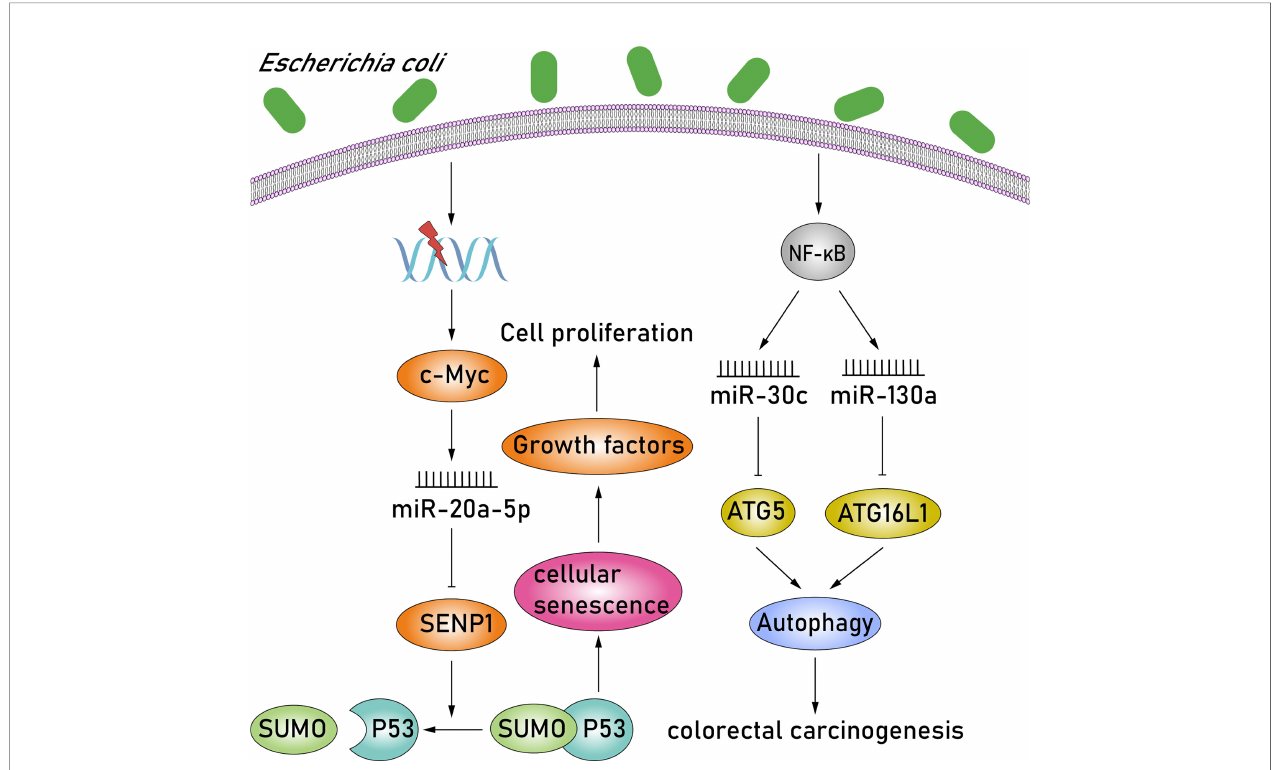
FIGURE 3 | E. coli promotes cell proliferation and in fl ammation by modulating miR-20a-5p, miR-30c, and miR-130a. In pks + E. coli – infected CRC cells, c-MYC is activated, and it subsequently results in the upregulation of miR-20a-5p. Upregulation of miR-20a-5p can cause the translational silencing of target SENP1. SENP1 is a key enzyme that blocks the modi fi cation of the SUMO1-conjugated p53 patterns. Moreover, the SUMOylation of p53 is identi fi ed as the key regulator of cellular senescence. The senescence of intestinal epithelial cells in pks + E. coli – infected CRC cells consequently induces the secretion of growth factors, which play a crucial role in stimulating tumor growth. In addition, expressions of miR-30c and miR-130a were also upregulated signi fi cantly in AIEC-infected epithelial cells via activating the NF- k B pathway. Overexpression of miR-30c and miR-130a subsequently downregulates the expression of ATG5 and ATG16L1, respectively. ATG5 and ATG16L1 are members of autophagy signaling elements, and their downregulation will result in defective autophagy. Moreover, dysregulated autophagy is associated with numerous human pathologies, such as colorectal